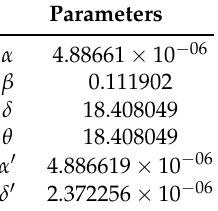
Table 1. Parameters for the Gompertz-Gamma model. General population. Initial age x 0 = 65.